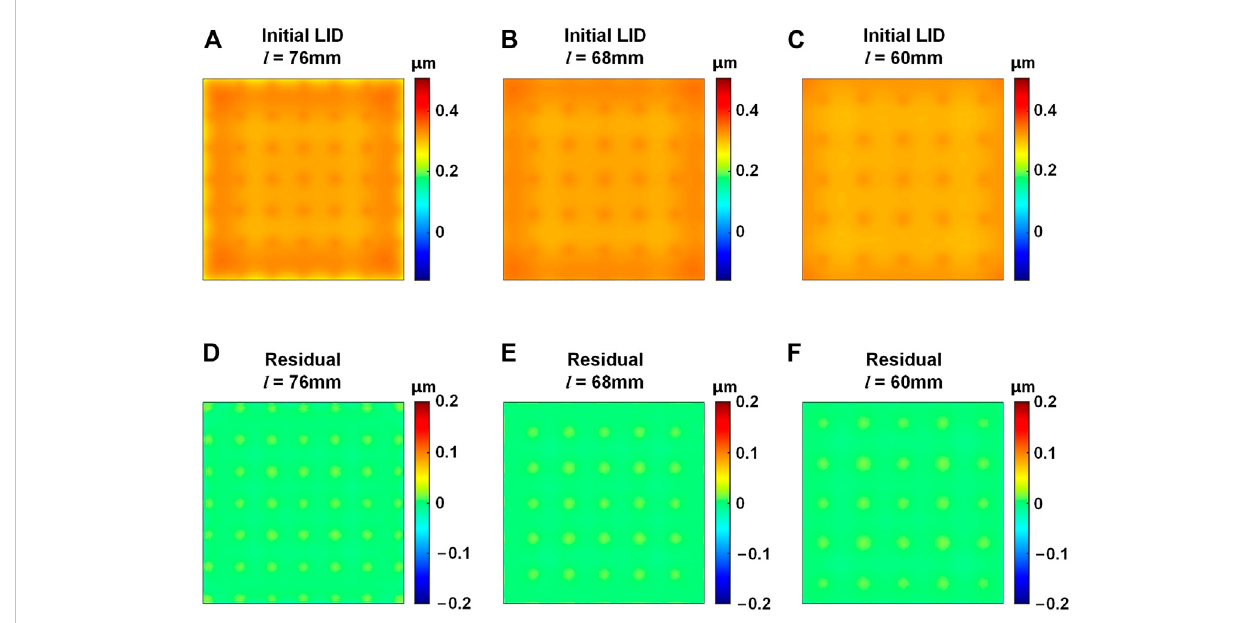
FIGURE 3 LIDoftheDDMwithdifferenteffectiveareasizes. (A – C) InitialLIDwiththeareasidelength l of76 mm,68 mm,and60 mm,respectively. (D – F) Self- correction residuals with the l of 76 mm, 68 mm, and 60 mm, respectively.